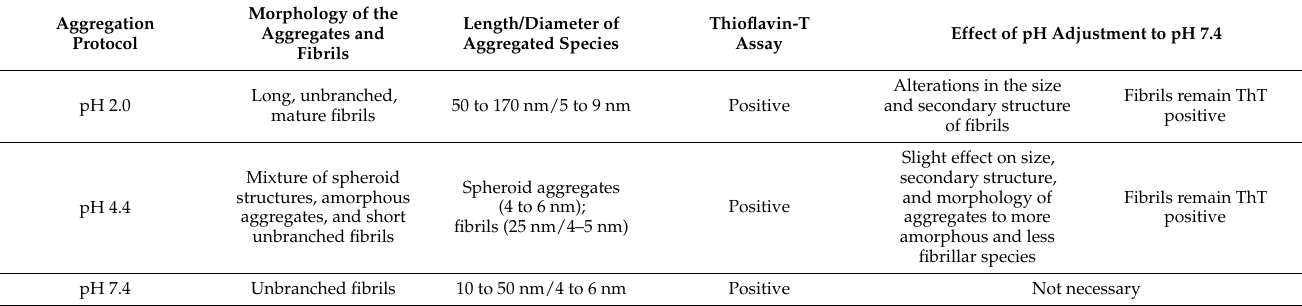
Table 2. Characterization of TTRwt amyloid species formed by different aggregation